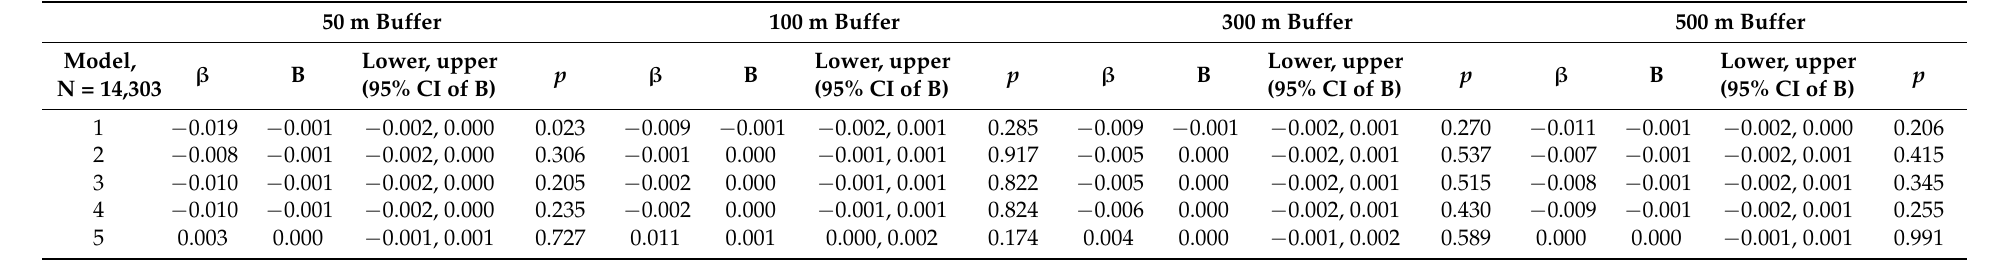
Table 4. Associations between residential greenspace at 50 m, 100 m, 300 m, and 500 m buffers, and burnout symptoms (whole sample/population).